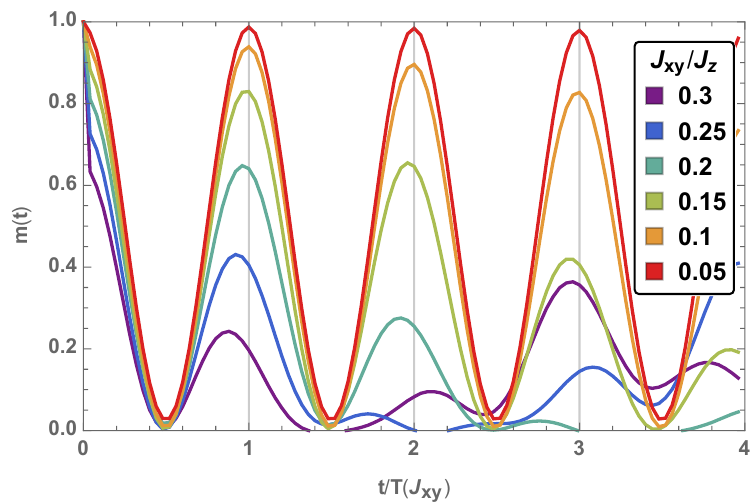
(cid:28) J , the exponentially long prethermal regime x y z ) given by Eq. (10). Here we show the magnetiza- x y / J = 0.05 − 0.3 for linear system size L = 6, with x y z